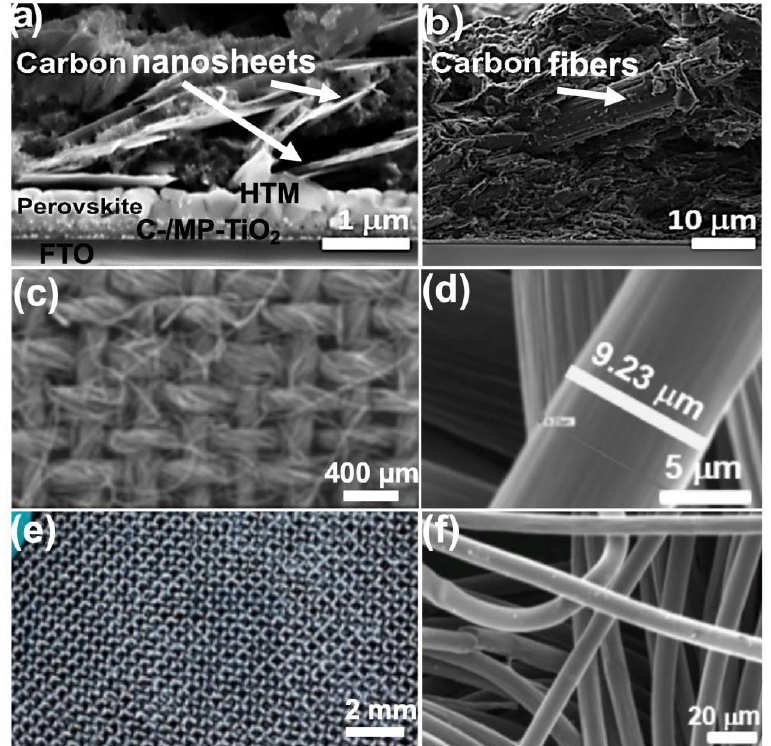
Figure 1. Cross-sectional FE-SEM images of the carbon-based PSCs ( a ), CC embedded in carbon paste/spiro – OMeTAD composition ( b ). Overview FE-SEM image of CC ( c ), and close-up image of a single fiber of the used CC ( d ). Digital image of CC ( e ); typical diameter of each carbon fiber is 9 μm according to the FE-SEM image of CC texture ( f ).